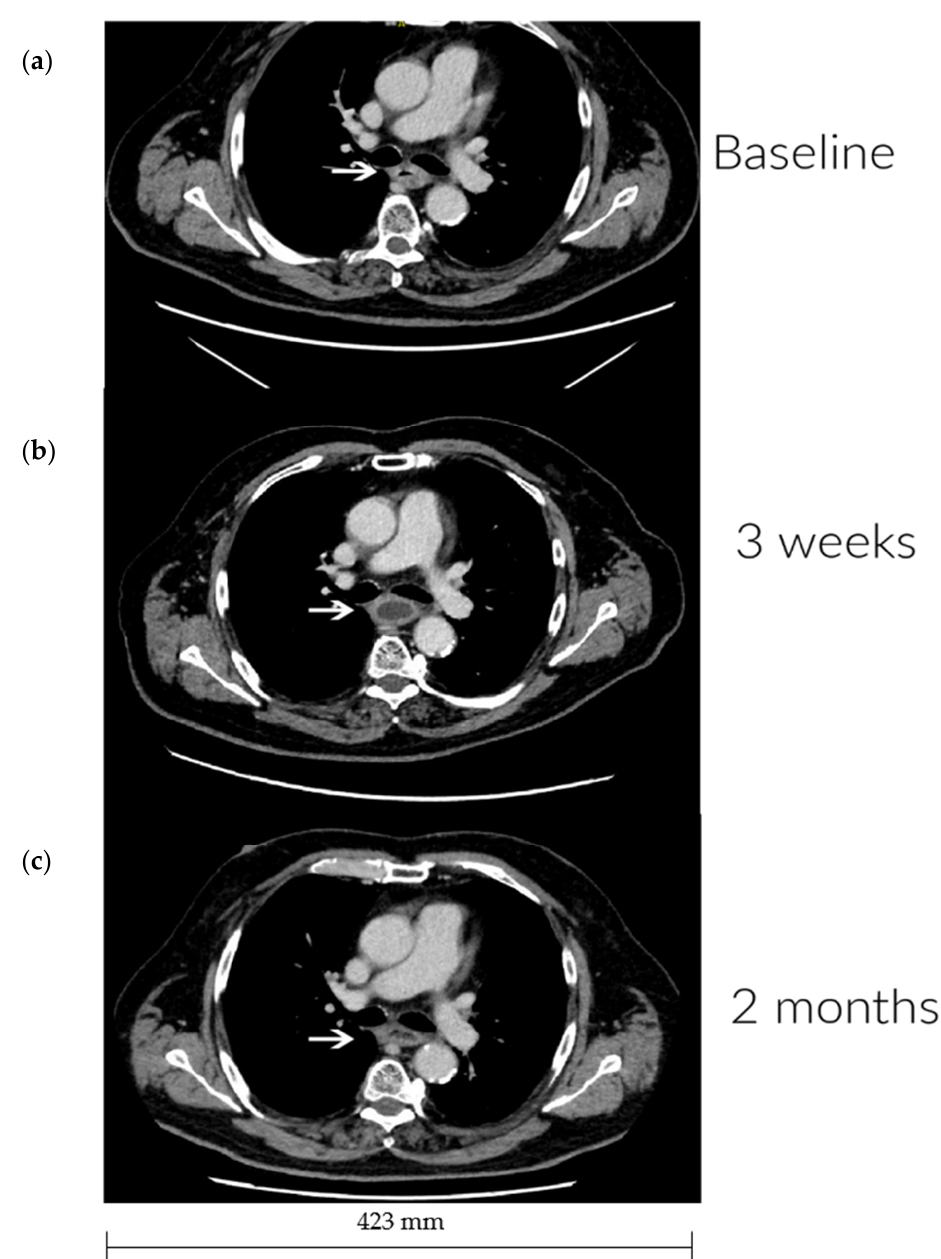
Figure 2. Imaging response. CT imaging at ( a ) baseline, ( b ) three weeks, and ( c ) two months after treatment. The arrows indicate the tumor localization in the thoracic part of the esophagus. ( a ) Largest esophageal wall thickness is 10 mm. A left main bronchial impression is seen due to tumor size. ( b ) Diminishing circumferential wall thickness corresponding to the treated area. The bronchial impression is no longer observed. ( c ) No further changes, stable disease.